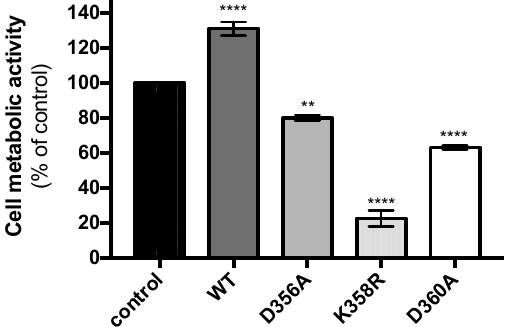
Figure 2. Expression of mutant rVPs bearing the D356A, K358R, and D360A substitutions in A549 cells. A549 cells were transfected at 18 h with pcDNA3/rVP (WT), pcDNA3/rVP-Ala 356–360 (Ala 356–360 ), pcDNA3/rVP-D356A (D356A), pcDNA3/rVP-K358R (K358R), or pcDNA3/rVP-D360A (D360A). In ( A ), an immunoblot assay was performed with anti-FLAG tag or anti-VP antibody. The α -tubulin protein served as a protein loading control. In ( B ), FACS analysis using anti-FLAG tag antibody was performed on mock-transfected (control) or transfected cells and the mean of fluorescence intensity (MFI) of rVP-positive cells is shown.